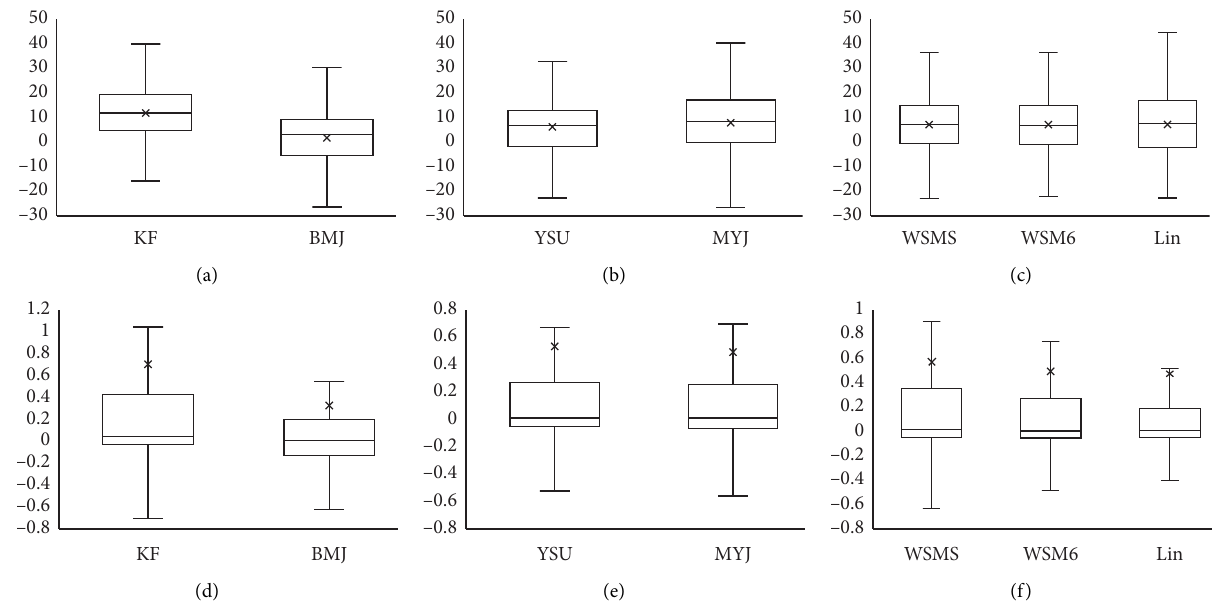
Figure 7: The box plots of bias in mm for each parameterization with their relevant options used. WS � wet season; DS � dry season in caption. (a) CU schemes WS, (b) PBL schemes WS, (c) MP schemes WS, (d) CU schemes DS, (e) PBL schemes DS, and (f) MP schemes